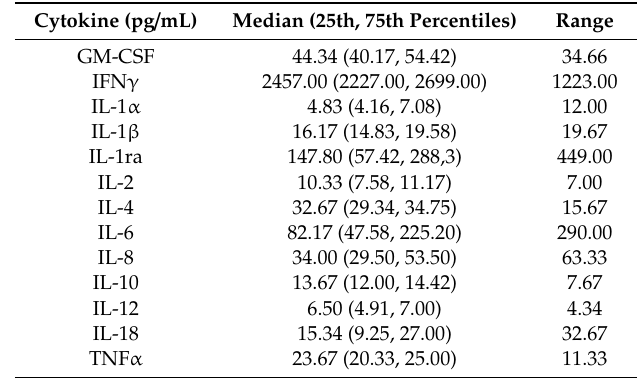
Table 3. Experiment 2: Cytokine concentrations in pig fresh seminal plasma samples (baseline samples, n = 22). Cytokines: Granulocyte macrophage colony-stimulating factor (GM-CSF), interferon-gamma